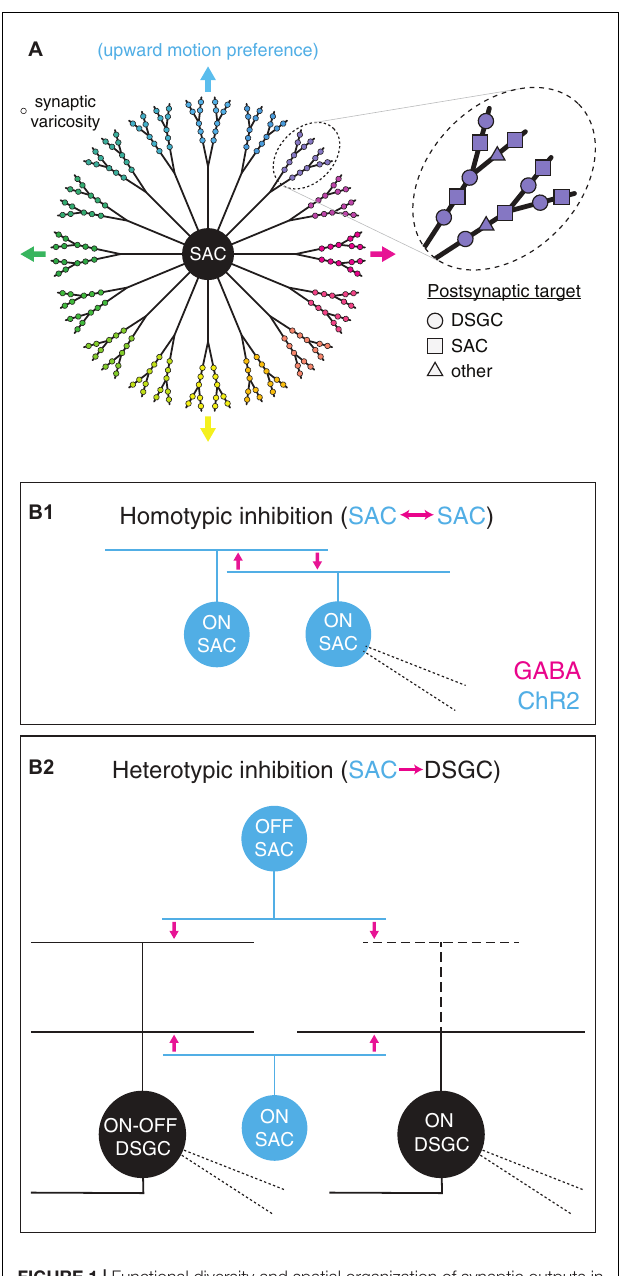
FIGURE 1 | Functional diversity and spatial organization of synaptic outputs in starburst amacrine cells. (A) Diverse properties of synaptic varicosities in a SAC. Left , functional parsing of SAC neurites into sectors with distinct preferences for direction of motion. Varicosity color indicates preferred direction. Arrows indicate cardinal directions. Right , expanded view of varicosities within one neurite sector. Varicosity shape indicates postsynaptic cell type identity. (B) An optogenetic approach to comparing GABAergic transmission from SACs to distinct postsynaptic cell types. (B1) Homotypic inhibition between SACs. Photostimulation of channelrhodopsin-2-expressing (ChR2 + ) ON SACs evokes reciprocal GABA release onto neighboring ON SACs. (B2) Heterotypic inhibition between SACs and DSGCs. Optogenetic stimulation of ON and OFF SACs evokes GABA release onto ON-OFF and ON DSGCs. Thick dashed lines indicate sparse or absent OFF-layer dendrites in ON DSGCs. Fine dashed lines indicate patch pipettes for targeted whole-cell